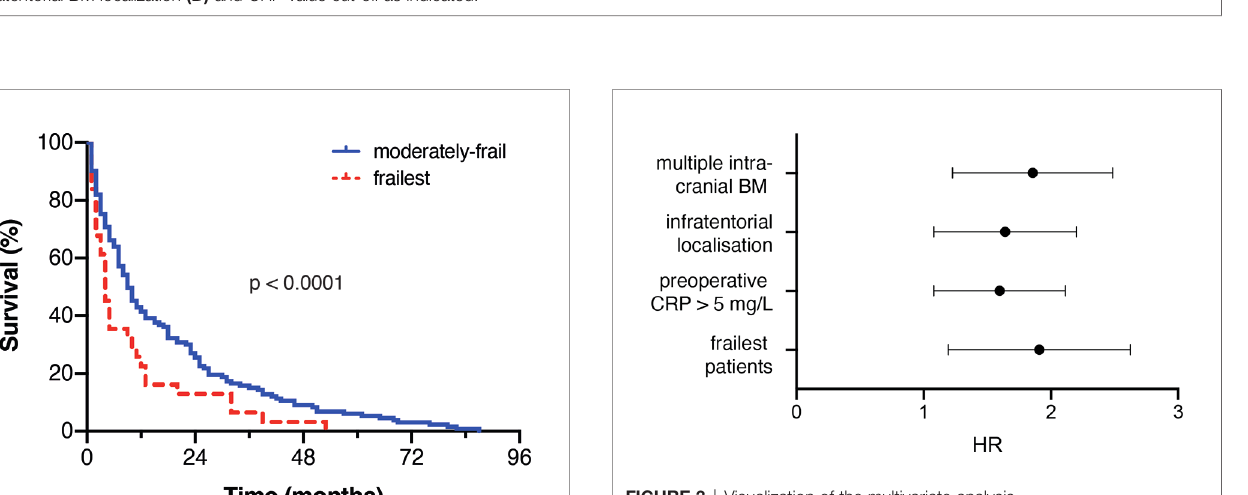
FIGURE 3 | Visualization of the multivariate analysis.